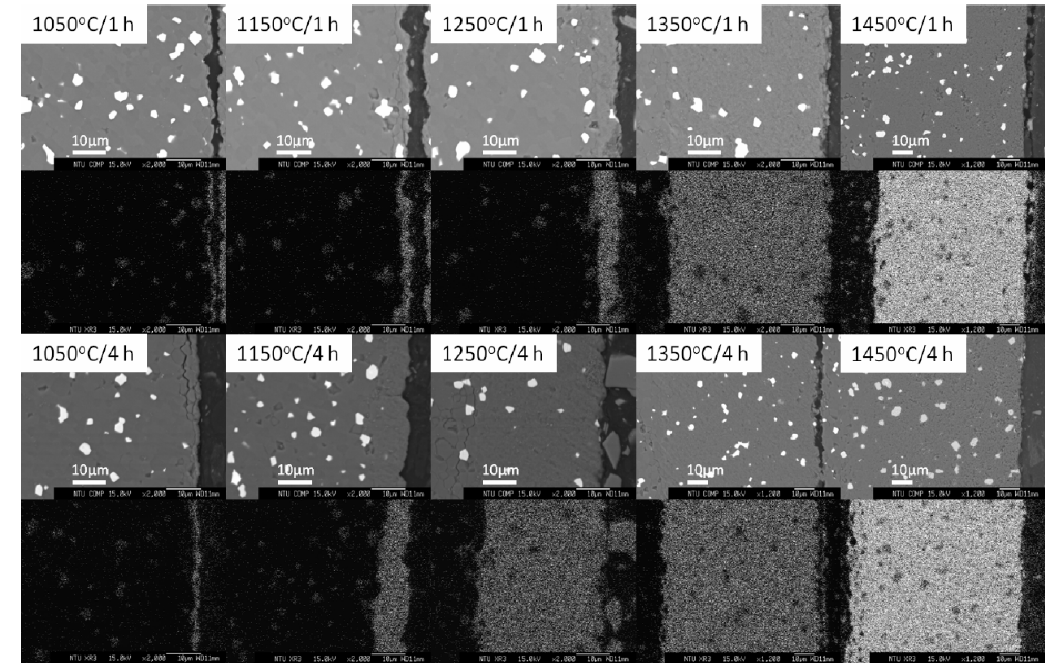
Fig. 1 SEM back-scattered micrographs for the surface region of oxidized AlN specimens and their corresponding maps of oxygen. Note that the magnification for micrographs of the specimens oxidized at 1350 ℃ /4 h, 1450 ℃ /1 h, and 1450 ℃ /4 h is lower.